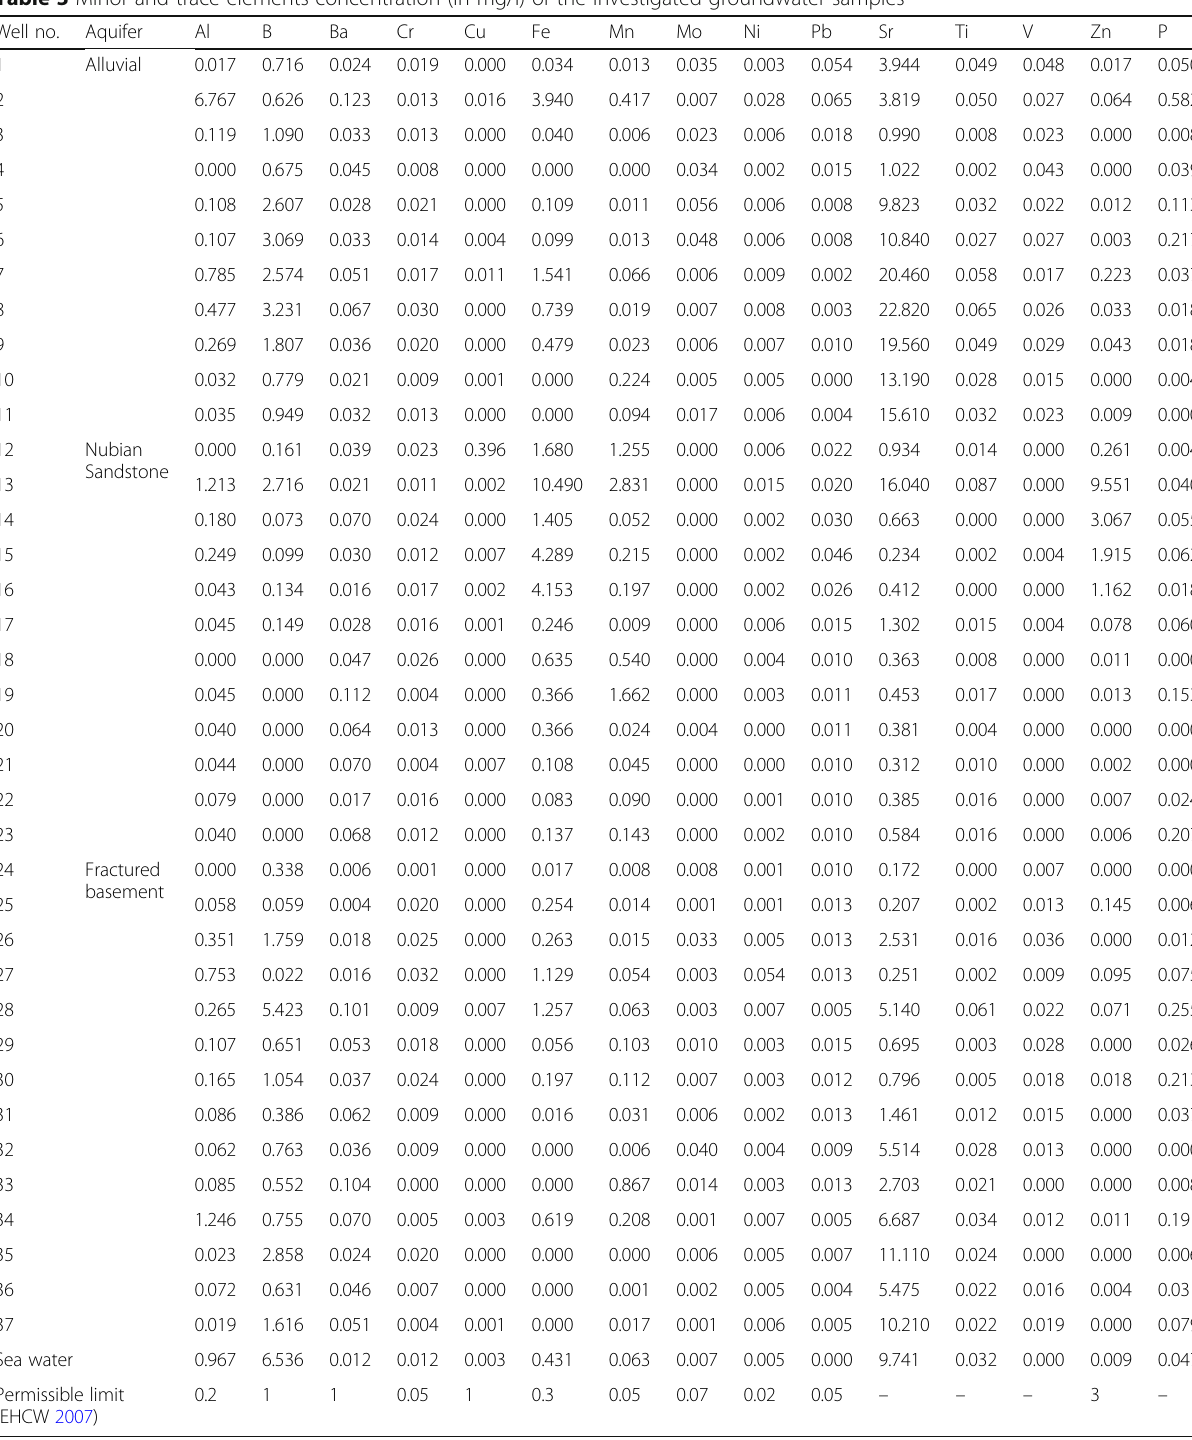
Table 3 Minor and trace elements concentration (in mg/l) of the investigated groundwater samples Well